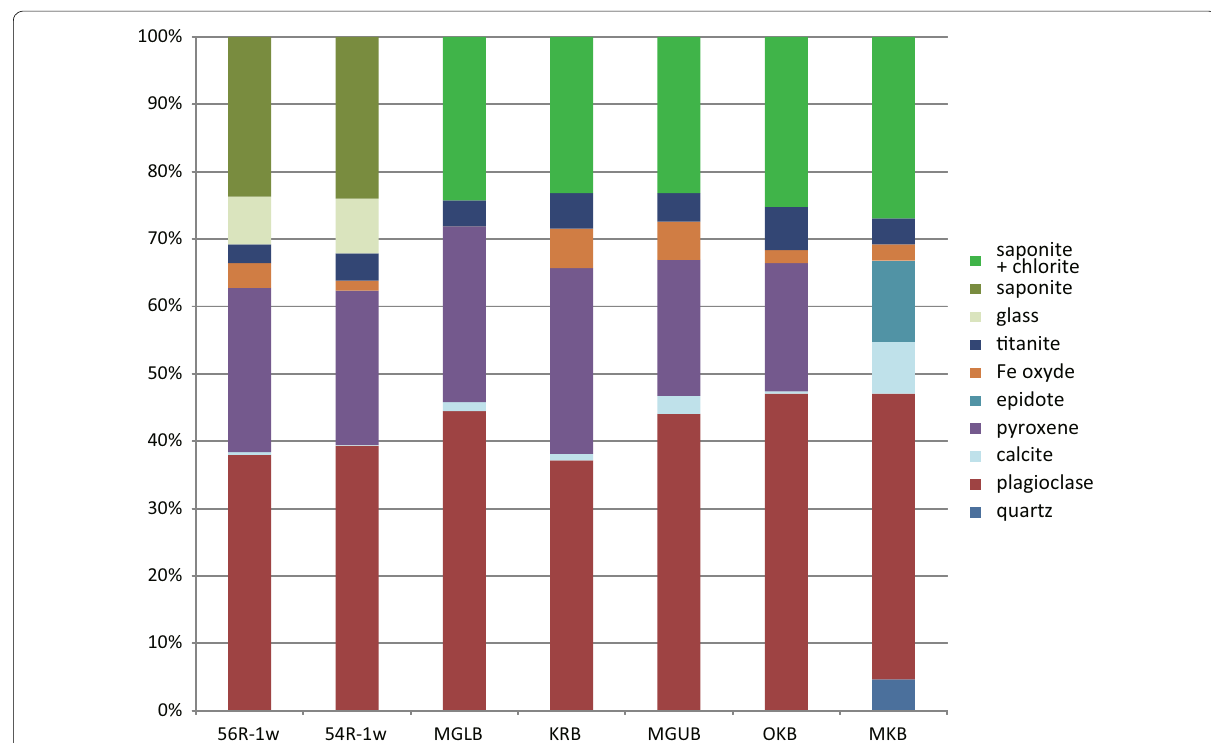
Fig. 4 Whole-rock mineral compositions determined using RockJock software. Data for core samples 56R-1w and 54R-1w are also